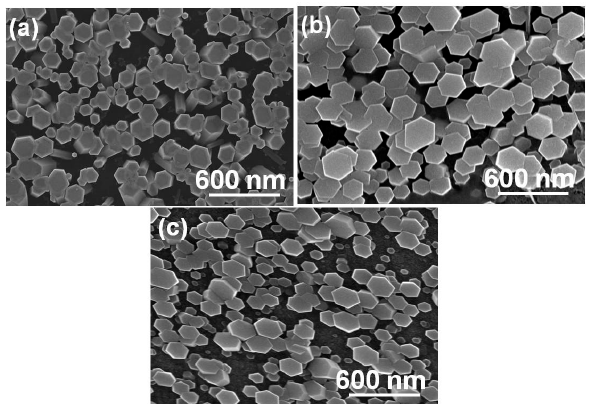
Figure 4. Surface morphologies of hydrothermally grown In 3 + -doped ZnO: ( a ) ZnO-4-In nanowires synthesized at 88 ◦ C, ( b ) ZnO-8-In nanowires synthesized at 75 ◦ C, and ( c ) ZnO-12-In nanowires synthesized at 60 ◦